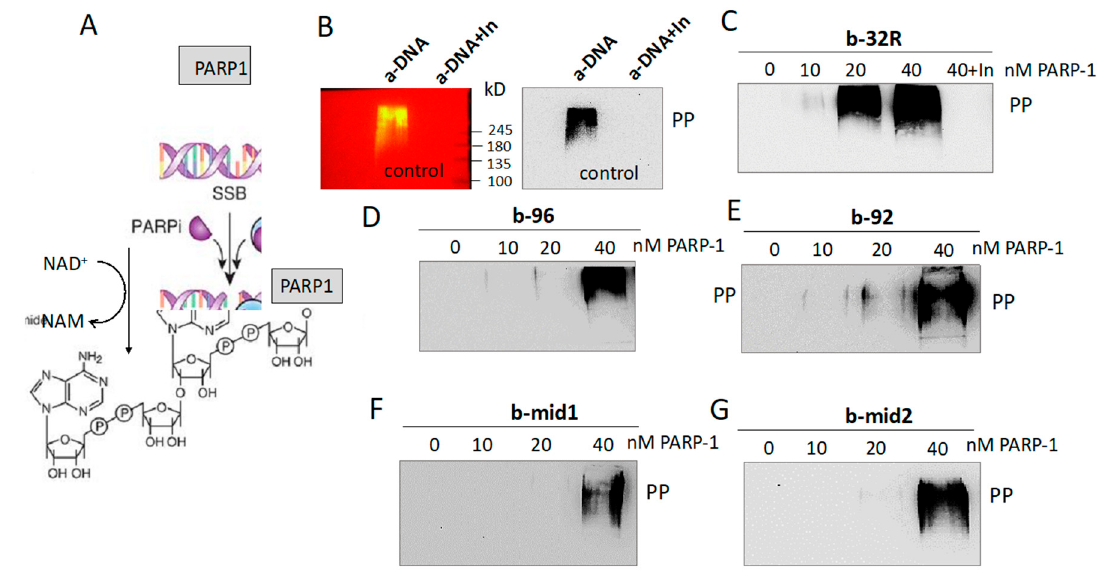
Figure 5. ( A ) The reaction of PARP-1 autoPARylation. NAM = nicotinamide; ( B ) AutoPARylation of recombinant PARP-1 induced by a-DNA (positive control from supplier). When Veliparib, an enzymatic inhibitor of PARP-1 (indicated with In), was added to the reaction mixture no PARylation was observed (negative control). The Western blot was performed with anti poly / mono ADP-ribose Ab and a secondary Ab conjugated to horseradish peroxidase. A membrane replica showing the protein markers (right) is also reported. PP = PARylated PARP-1; ( C – G ) AutoPARylation of recombinant PARP-1 (P) induced by KRAS G4 32R ( C ), 96 ( D ) and 92 ( E ) quadruplexes and G4 mid1 ( F ) and mid2 ( G ) quadruplexes. The mixtures contained 10, 20 and 40 nM of PARP-1 and 10 nM G4.